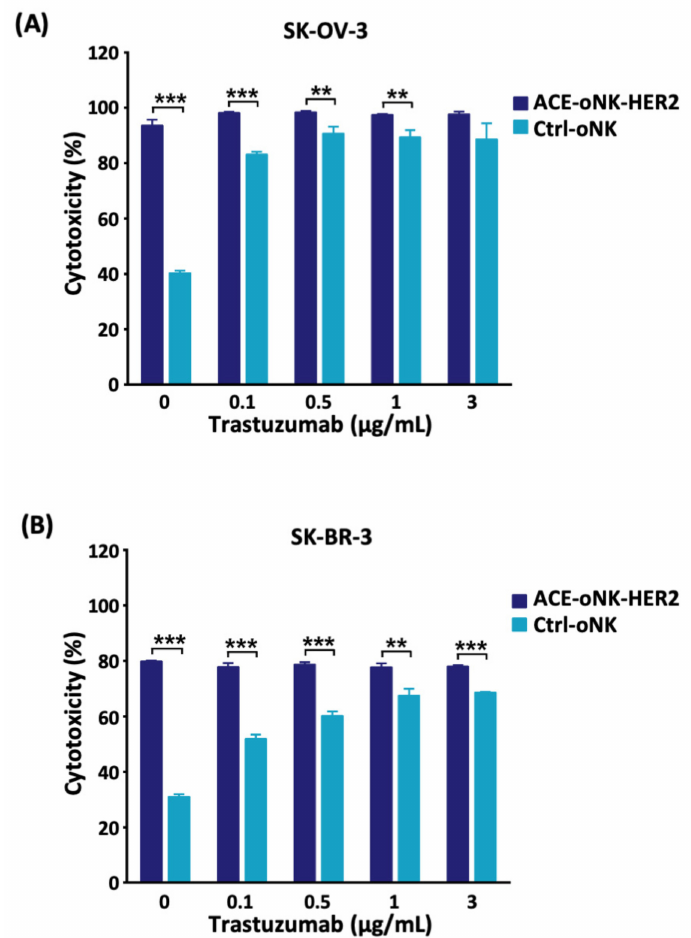
Figure 4. ACE-oNK-HER2 shows better cytotoxicity than ADCC of Ctrl-oNK. ACE-oNK-HER2 and Ctrl-oNK were incubated with HER2 + cancer cell line ( A ) SK-OV-3 and ( B ) SK-BR-3 in the presence of various trastuzumab concentrations (0, 0.1, 0.5, 1 and 3 µ g/mL) in triplicate. The cytotoxicity of ACE- oNK-HER2 and Ctrl-oNK against SK-OV-3 and SK-BR-3 cells was measured and calculated by xCEL- Ligence real-time cell analysis system. Three independent experiments were performed and the rep- resentative results were shown. Cytotoxicity was compared between treatments by t test. **, p < 0.01; ***, p <